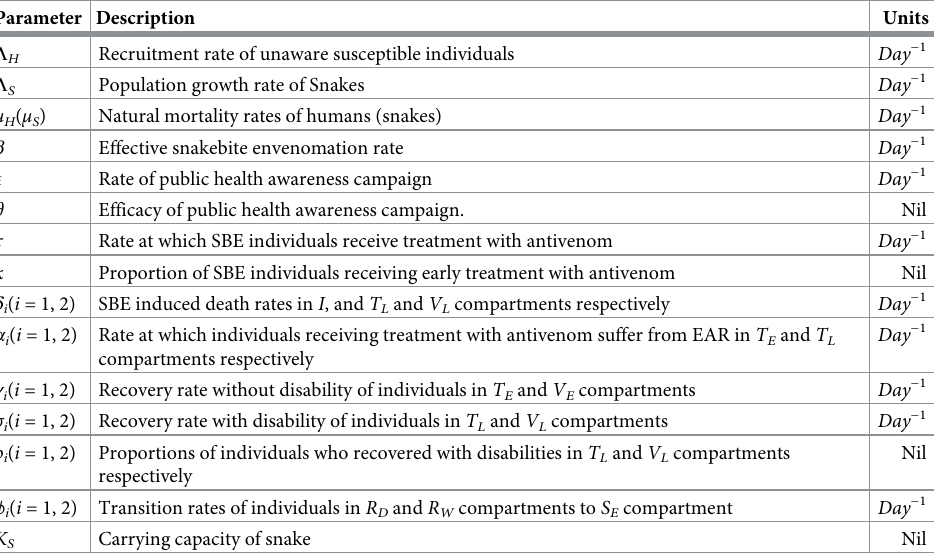
Table 2. Description of parameter of the model. Parameter